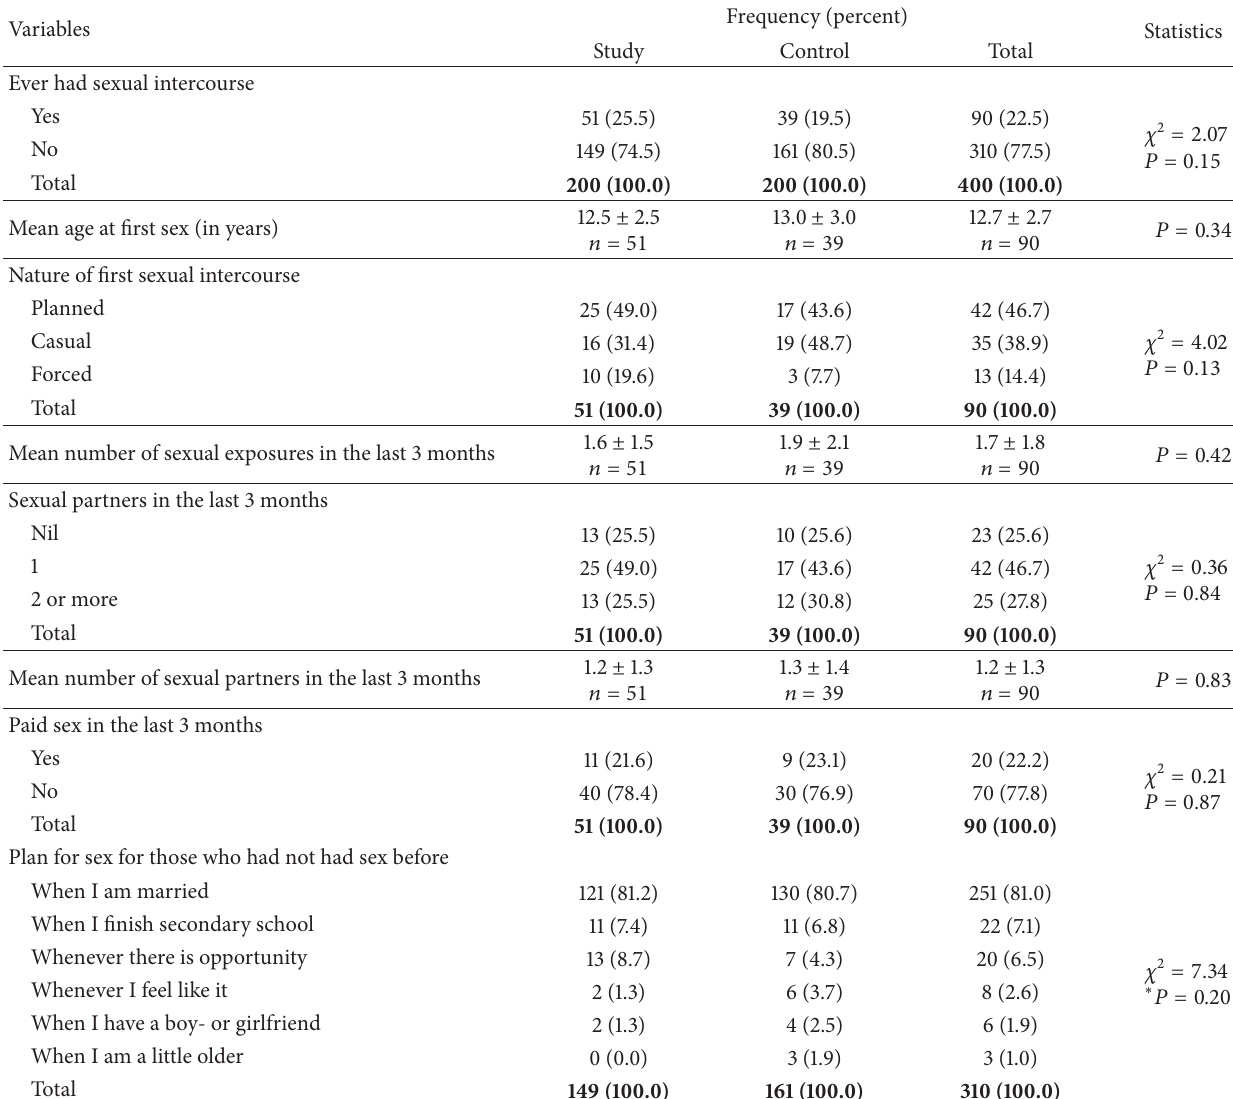
Table 4: Respondents’ sexual exposure at the preintervention